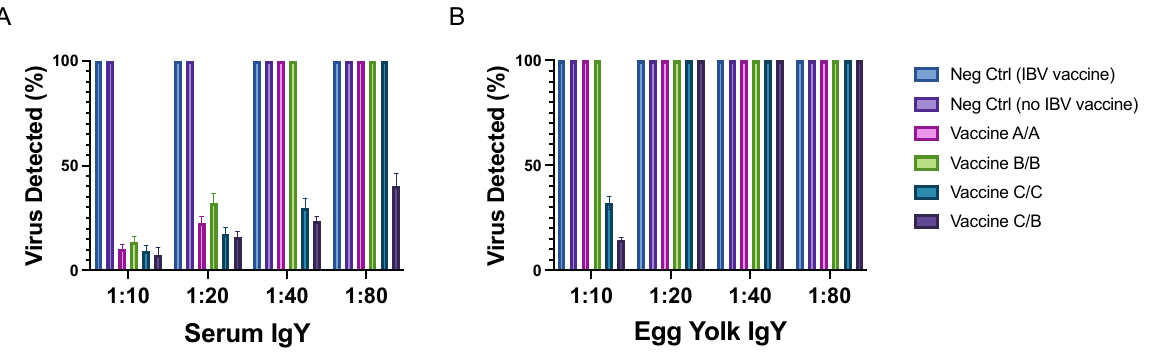
Figure 4. A plaque reduction neutralization assay (PRNA) was performed to detect SARS-CoV-2- specific neutralizing antibodies in ( A ) sera and ( B ) egg yolk IgY extractions from hens receiving 50 μ g of vaccine A/A, B/B, C/C, and C/B. Controls included negative control hens that were either vaccinated or not vaccinated for IBV. Sera was collected at three weeks after the second vaccination, and egg yolk was harvested beginning at six weeks after the second vaccination. Viral titer of SARS- CoV-2 was determined by counting the number of plaques and represented as relative percentage of neutralization with respect to the negative control. The PRNA was performed in triplicate.